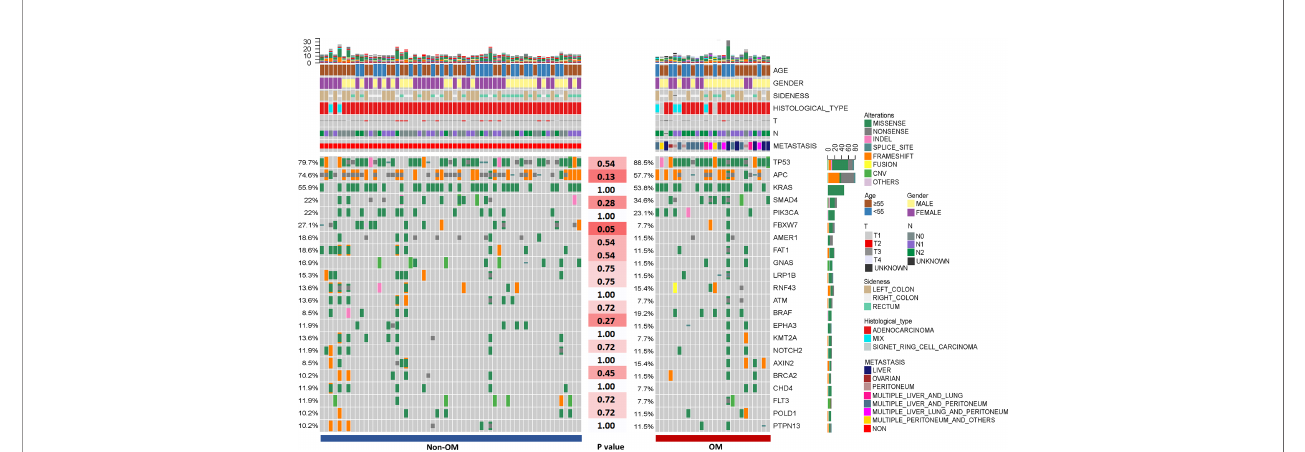
FIGURE 1 | The clinical information and mutational spectrum of the colorectal patients in this study. Comparison of the mutational pro fi le between the Non-OM and OM subgroups. The top 21 genes of the NGS cohort and P-values according to the Fisher ’ s exact were shown.